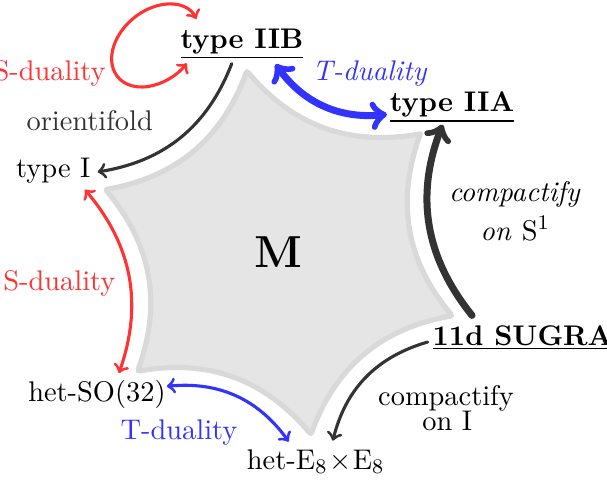
Figure 1 . A schematic of the web of dualities between the five 10-dimensional string theories and 11-dimensional supergravity (and M-theory). We will use the superspace generalization of this web to investigate the expansion in fermions of the superfields in different theories, and the expansion in fermions of the actions for the branes those theories contain. The parts of the web relevant for this work have been highlighted with thicker arrows. We begin with the superspace formulation of 11-dimensional supergravity. We find the expansion in fermions of the superfields therein, and use these to find the fermionic expansion of the M2-brane action. Compactification on S 1 is then performed in order to obtain the fermionic expansion of the fields in type IIA, and of the D2-brane action. Finally, T-duality between type IIA and type IIB is used repeatedly to obtain expansions of the fields in type IIB, and so the expansions for D p -branes for all p